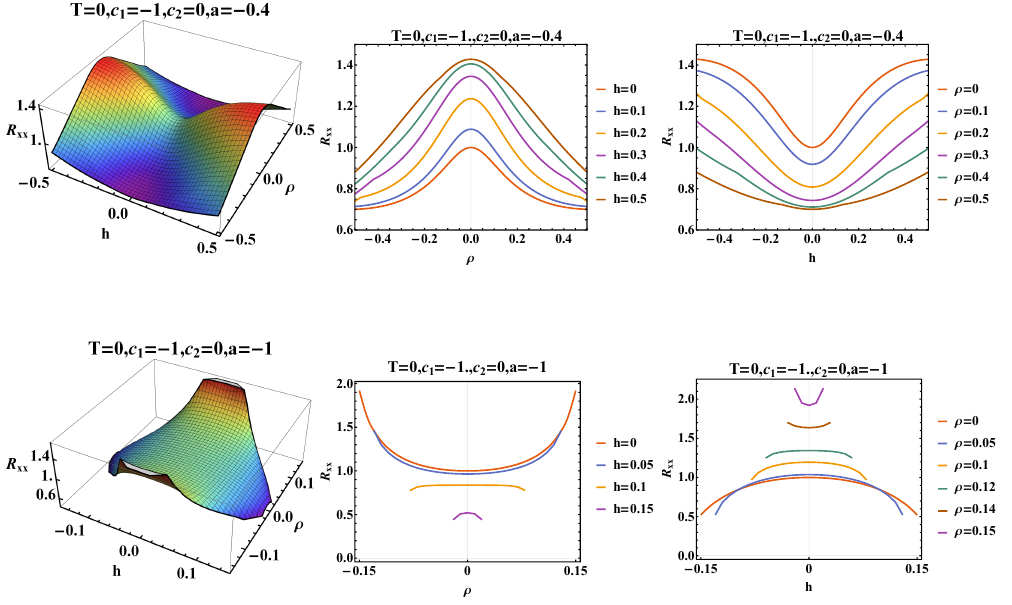
Figure 12 . R xx as a function of h and ρ and some intersection curves for fixed h and ρ for a = − 0 . 4 (upper panel) and a = − 1 (lower panel). The surface ends at some place where h and ρ touch the upper